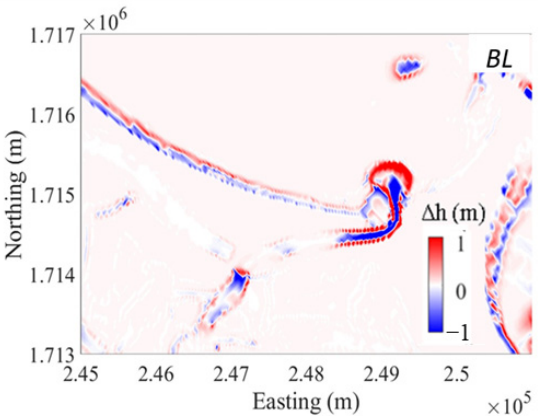
Figure 13. Current field in the flood tide ( upper panel) and ebb tide ( lower panel) during the North- east monsoon under current condition.